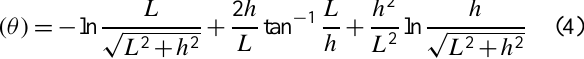
Fig. 8. Straight line (red) for Pulacayo zinc values fitted by constrained least squares to 10 variogram values taken from Matheron (1964). Horizontal axis is for f ( θ ) . Line was forced through the point where f ( θ ) = 0 and h =0 (cf. Eq. 4). Its slope β = 0.0988 yields estimate of absolute dispersion α (= 0.0165). Best ‐ fitting line without constraint (black), that is significantly different, is shown for comparison. 35